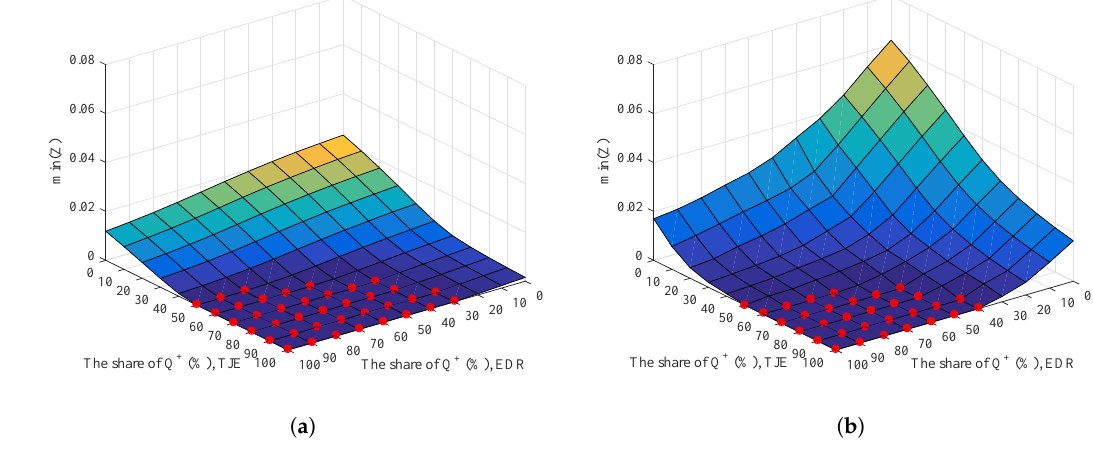
Figure 12. The values of min(Z) under different scenarios for an A–B fault at IDU: ( a ) the original system. ( b ) with three SGs (ESVB3, SKVB3 and NJVB3) phased